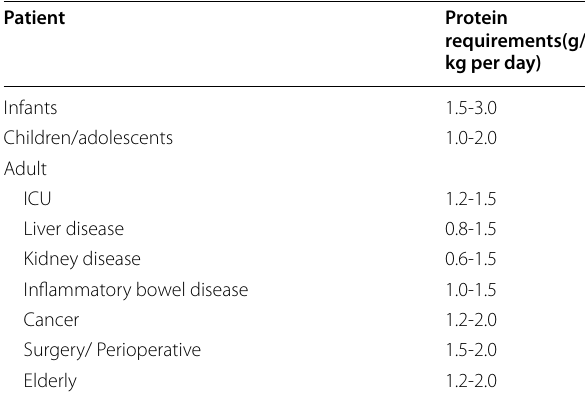
Table 5 Recommended doses for KD-PN of electrolytes, vitamins, and